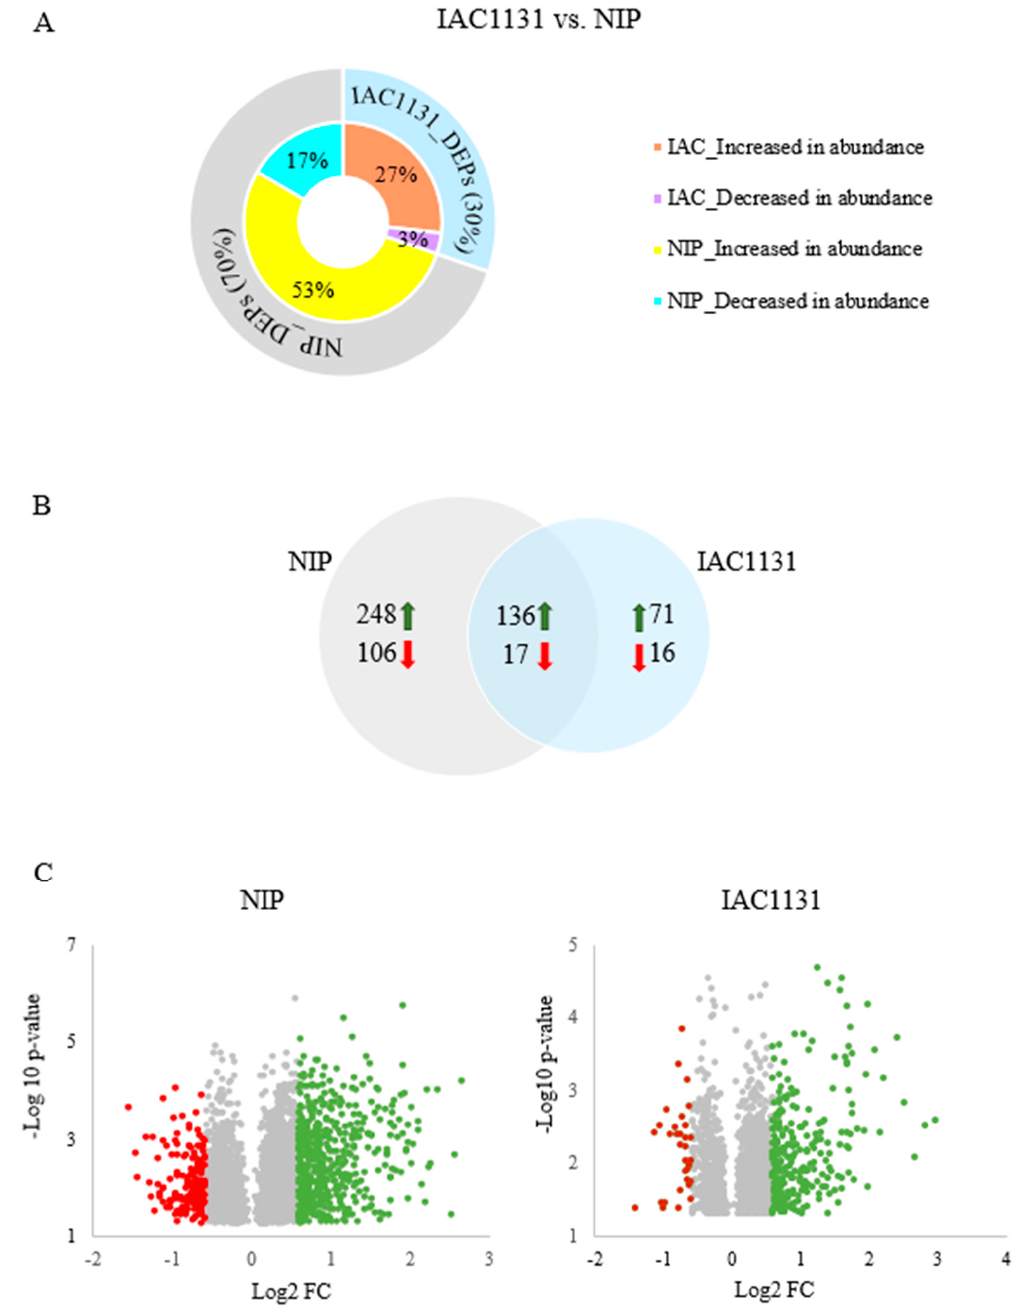
Figure 3. Differential protein expression of two rice genotypes after multiple abiotic stress treatment. ( A ) Polar plot of number of significantly differentially expressed proteins in each variety. ( B ) Unique and common differentially abundant proteins between IAC1131 and Nipponbare. ( C ) Fold change of DEPs in both genotypes after stress treatment.